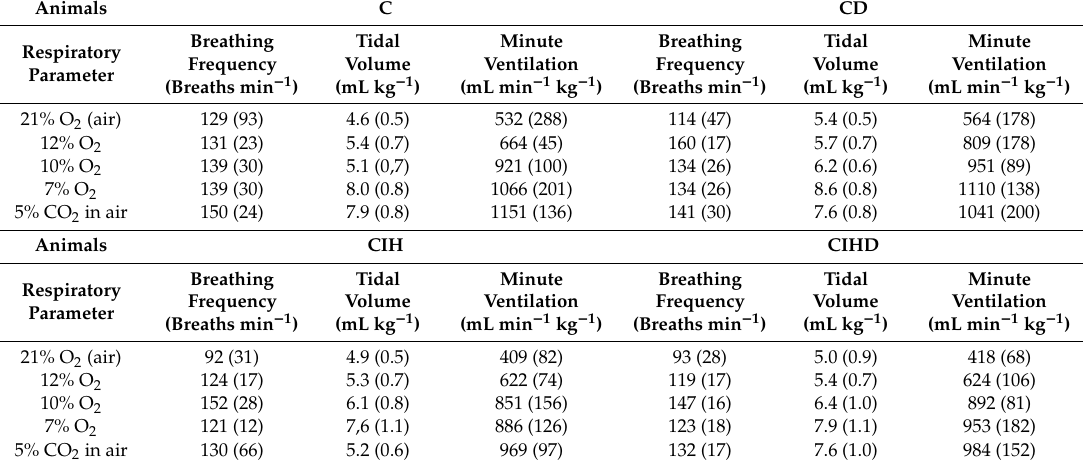
Table 1. Respiratory parameters in control and chronic intermittent hypoxia animals and the e ff ect of chronic domperidone treatment. The table shows breathing frequency, tidal volume and minute volume from the four group of animals breathing at di ff erent atmospheres. Data are mean and SD of eight individual values in each group. In the upper part control (C) and control with DOM (CD; 15 days with 0.75 mg / day of DOM treatment). In the lower part the same respiratory parameters from animals exposed to intermittent hypoxia during 30 days (CIH) and CIH treated with DOM (CIHD; 0.75 mg / day during 15 days). Two-way ANOVA showed no statistical di ff erences among